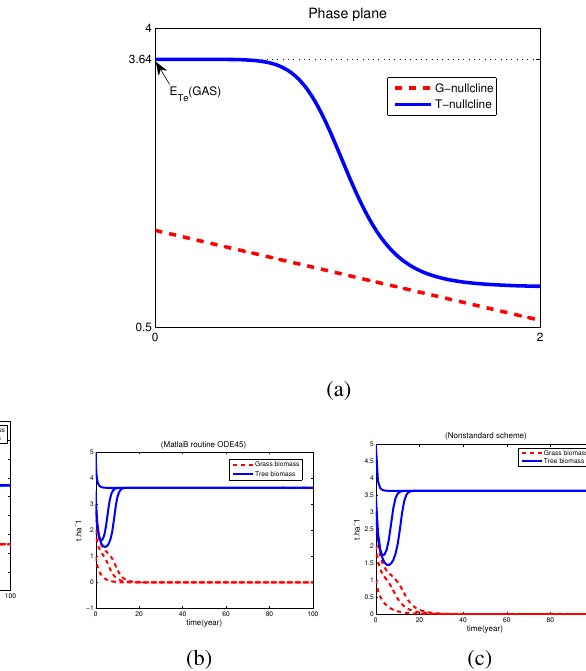
Fig. 10: The phase plane (a) shows two domains of attraction. Fig. 11: (a): when τ = 1 , there is no Tree-Grass equilibria. The The system may move from one domain to another. Then, it can be = (0;3 . 64) is globally asymptotically stable. These equilibrium E T = (0;3 . 64) (figure (b)) to E ∗ = flipped from a stable state E T e 3 e figures are done for λ fT = 0 . 8 , λ fG = 0 . 6 , τ = 1 and γ TG = (1 . 695;2 . 32) (figure (c)) by crossing the unstable intermediate point 0 . 19 . Simulations are done with (b) the standard ODE45 E ∗ τ = 2 . 2 . Here